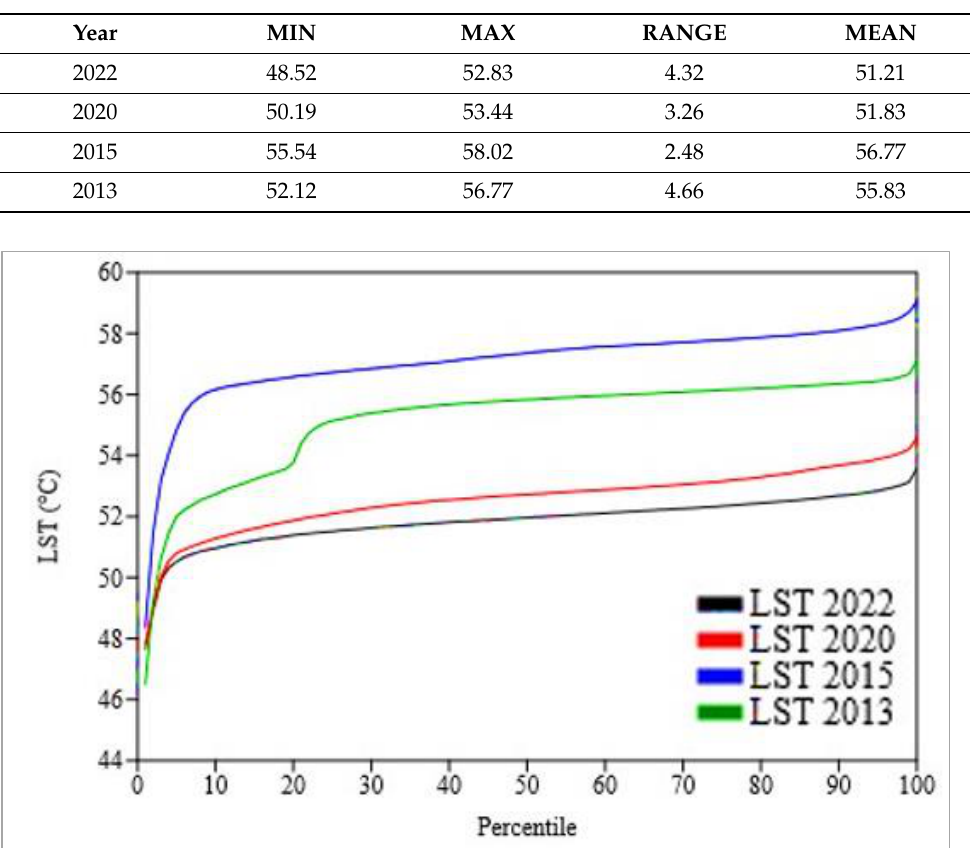
Figure 9. The trend of land surface temperature (LST) value changes in 10 percentiles according to the studied years.